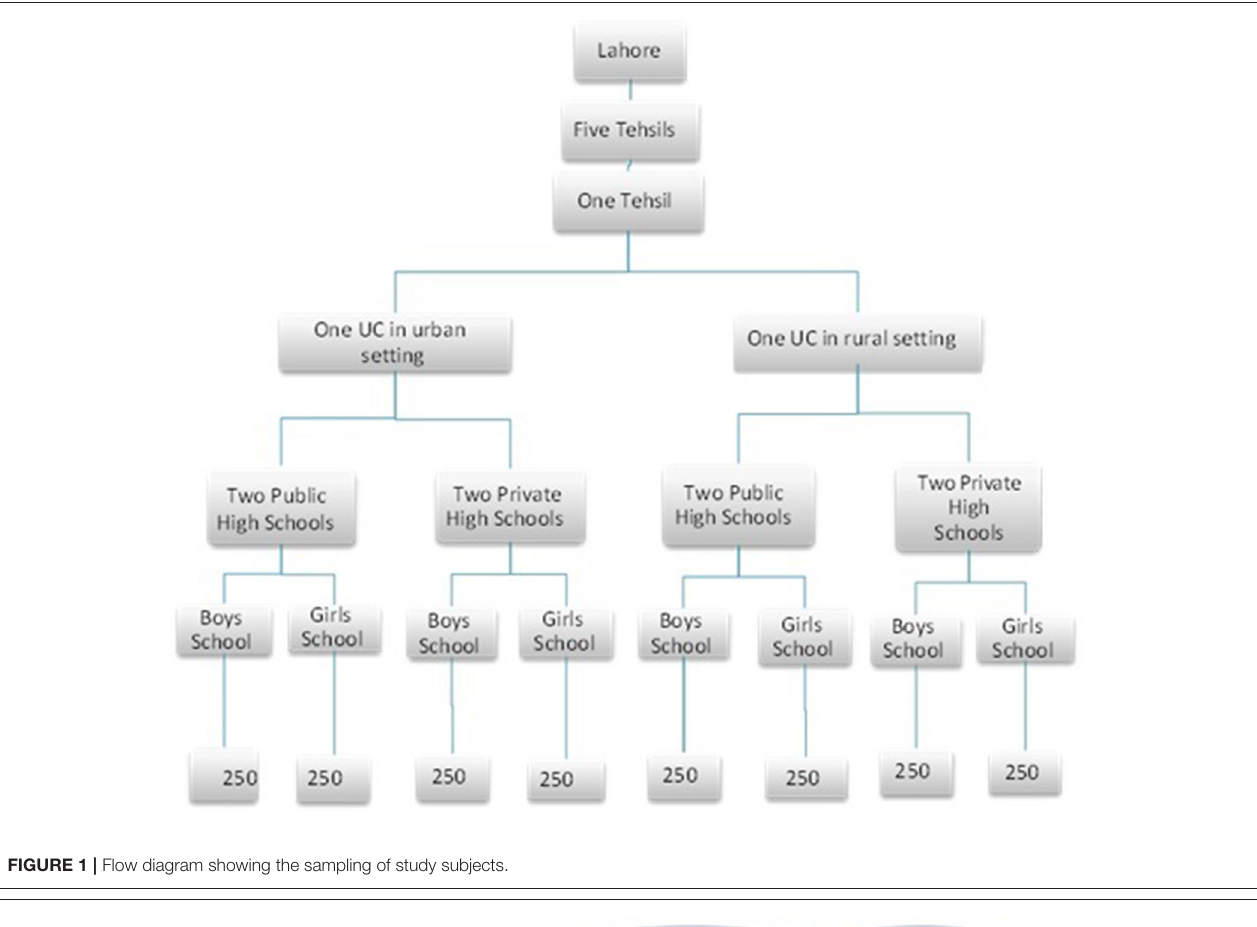
FIGURE 1 | Flow diagram showing the sampling of study subjects.